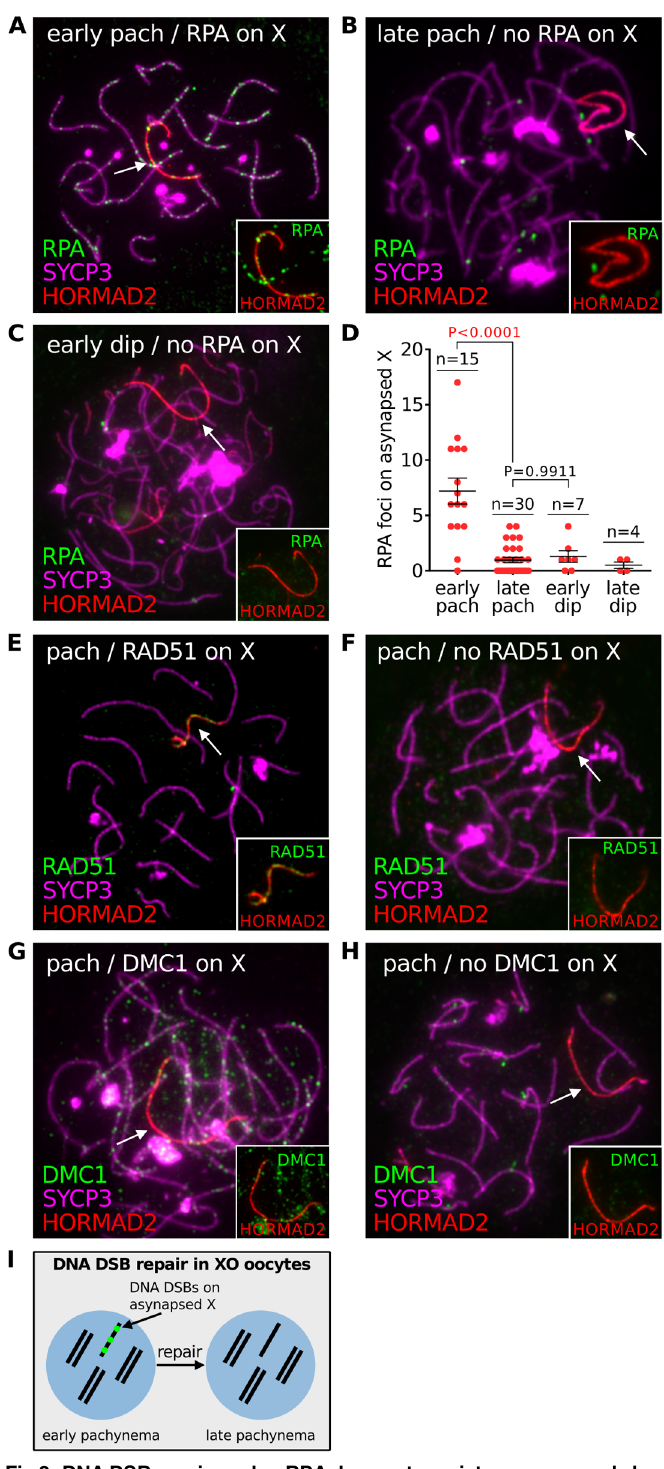
Fig 2. DNA DSB repair marker RPA does not persist on asynapsed chromosomes in XO female mice. ( A ) Early pachytene XO oocyte with numerous RPA foci on the asynapsed X chromosome, marked by HORMAD2 (arrow, inset). RPA foci are abundant on synapsed axes at early pachynema. ( B ) Late pachytene XO oocyte with no RPA foci on the asynapsed X chromosome (arrow, inset). RPA foci are less abundant on synapsed axes at late pachynema. ( C ) Early diplotene XO oocyte with no RPA foci on the asynapsed